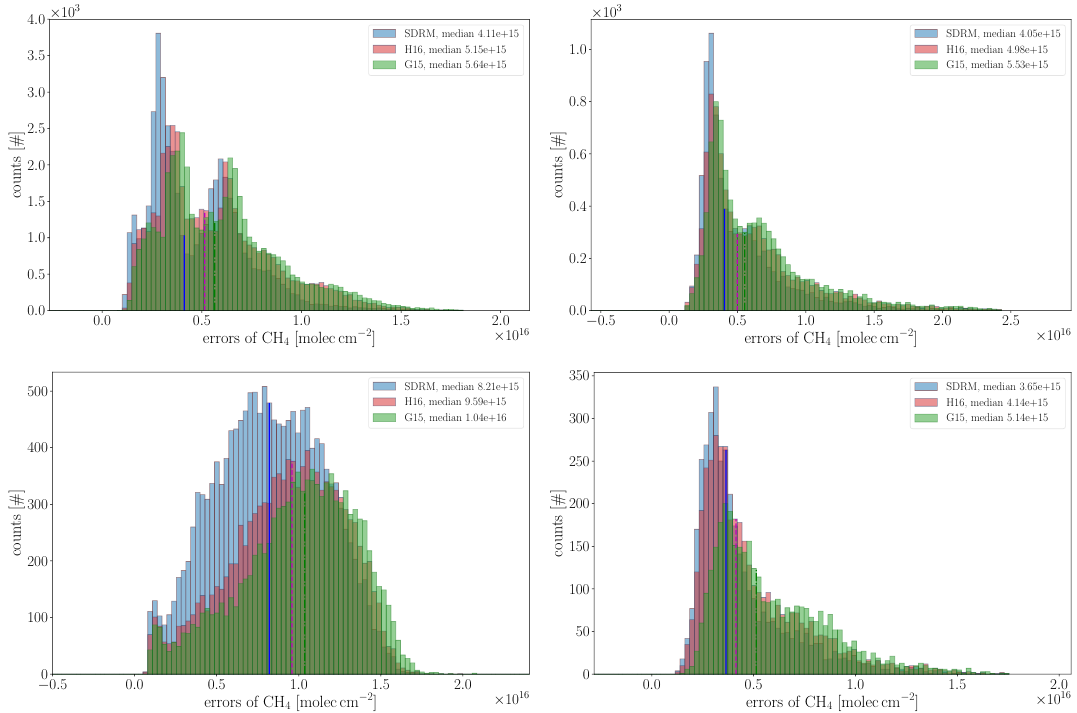
Figure A1. Errors of the CH 4 columns for Sahara, Central-Europe, Amazonia and Siberia (clockwise from top-left).